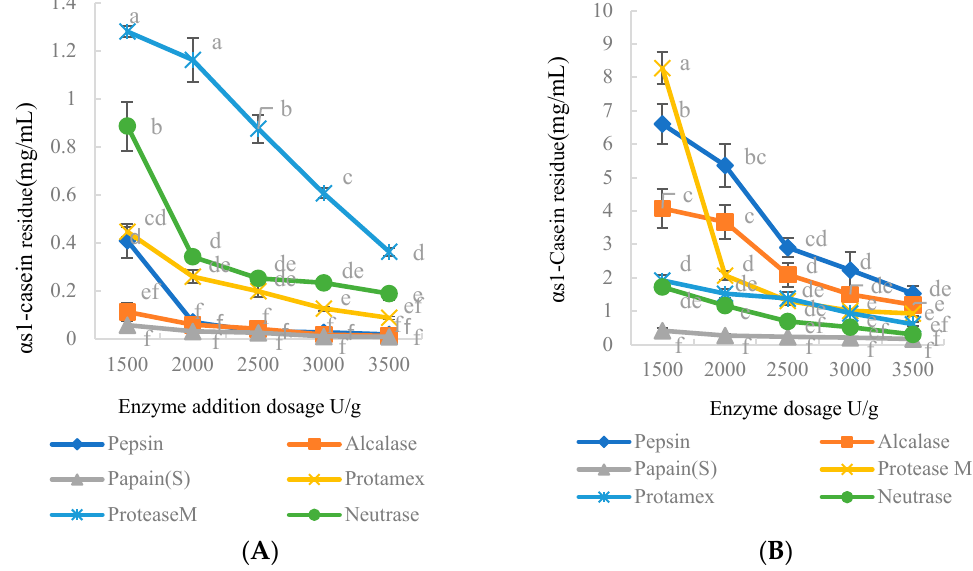
Figure 4. Antigen residues of hydrolysates using mAb against α s1 -casein epitope ( A ) and α s1 -casein protein ( B ). a-f indicates the significance of the data differences